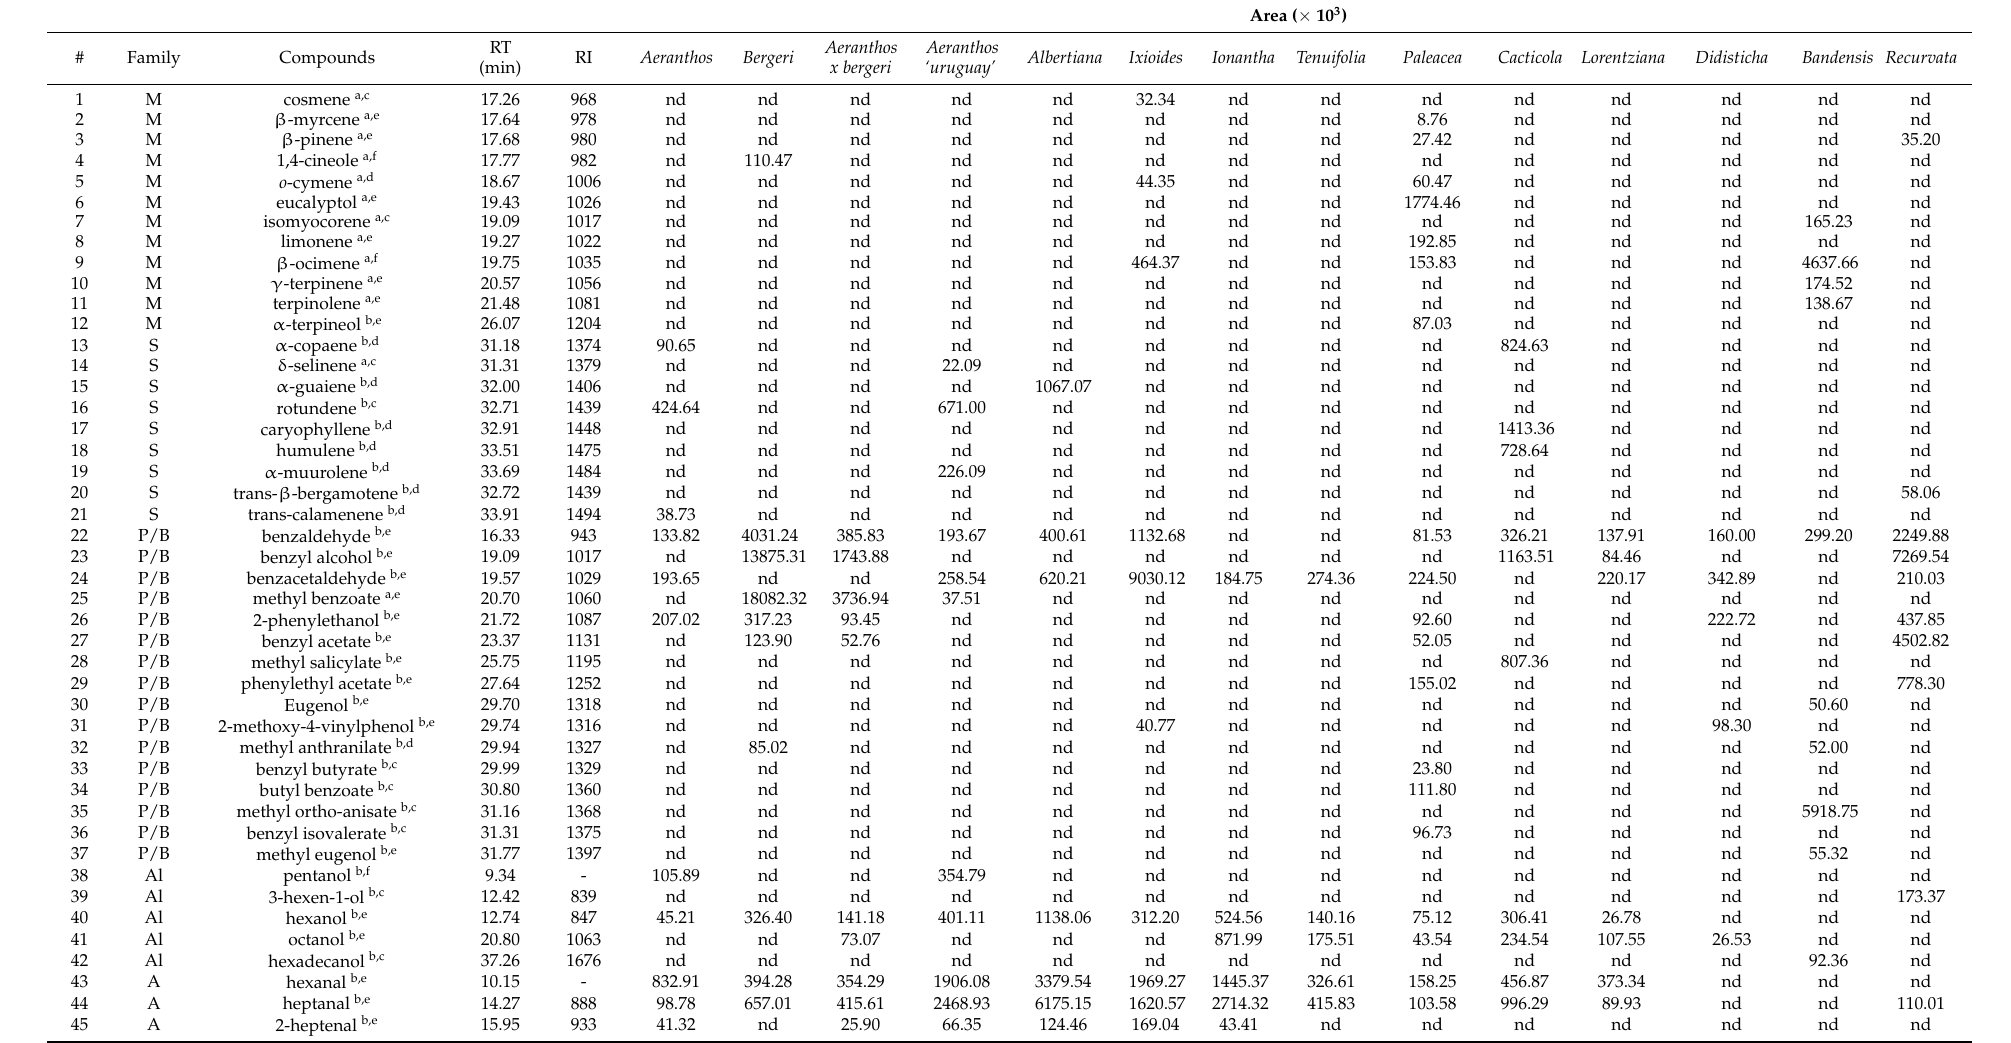
Table 2. Identification of the volatile organic compounds from floral emissions of the 14 Tillandsia species